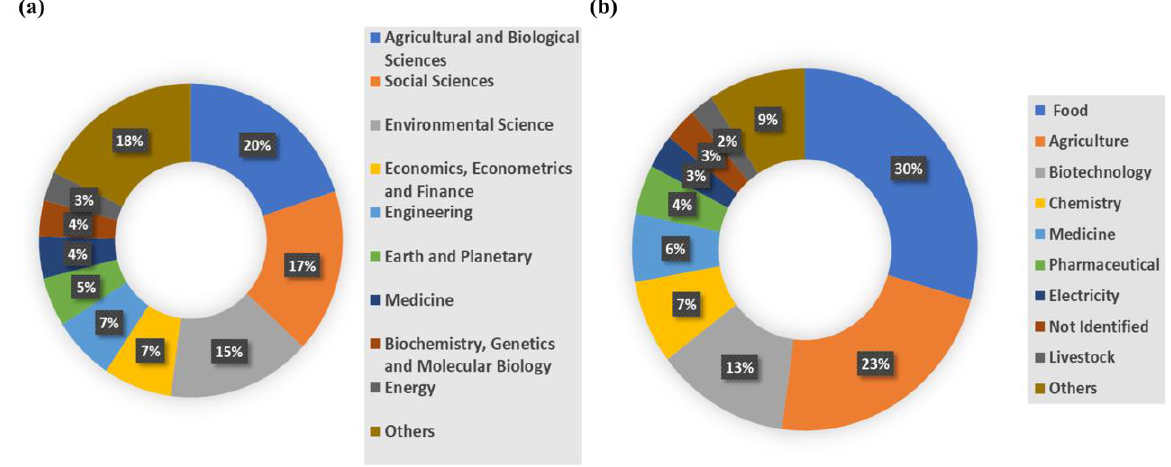
Figure 3. Areas of application for the published articles ( a ) and patent documents ( b ) on the partici- pation of family farming in the development of new food products.